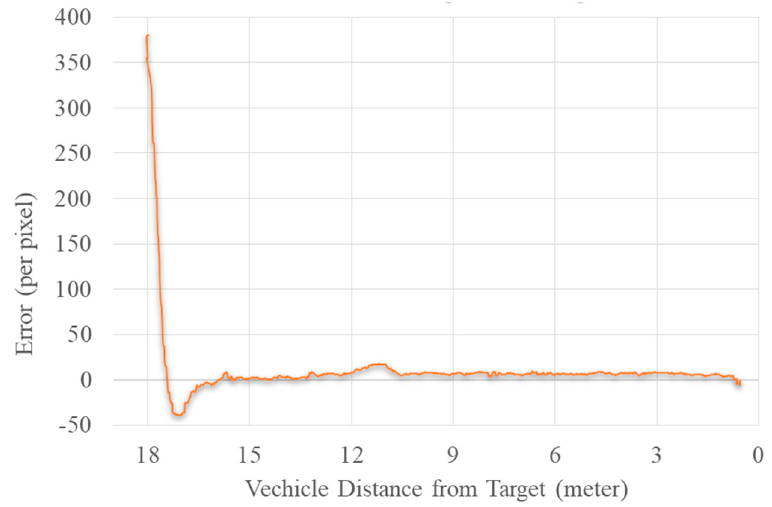
Figure 19. Plot diagram of the error between the image and target center vs. distance.